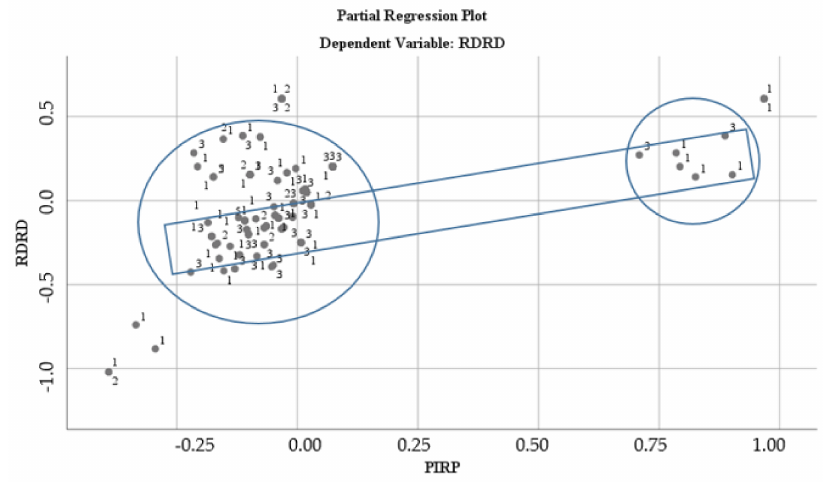
Figure 14. Regression analysis for PIRP.